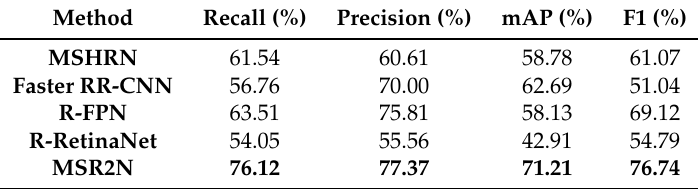
Table 7. Experimental results of different methods on hard